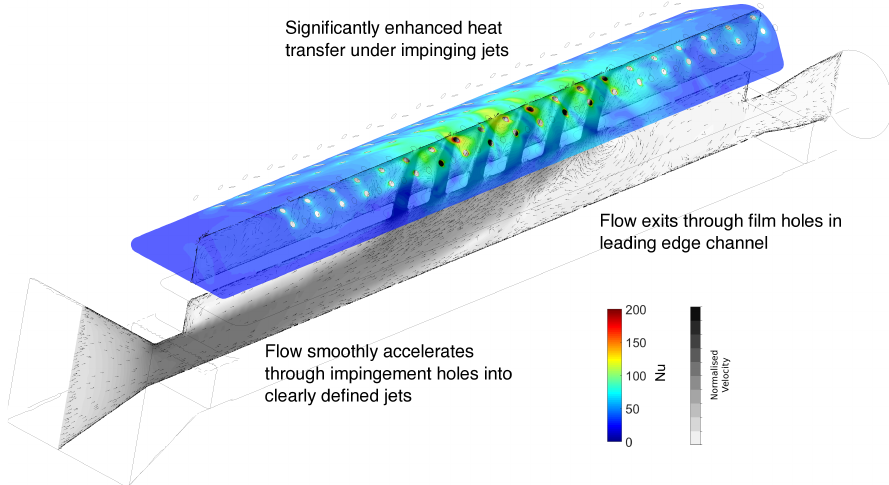
Figure 1. Computational fluid dynamics (CFD) results showing representative flow structure—velocity distributions in grayscale, surface heat flux in